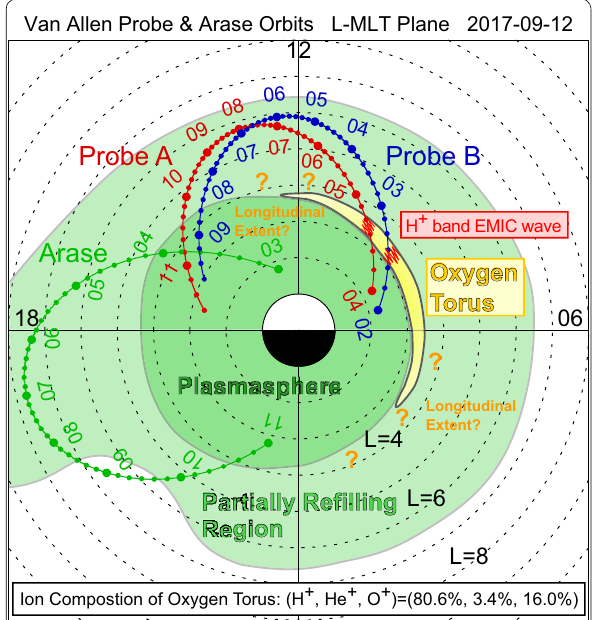
Fig. 11 A schematic figure summarizing findings of the present study for the 12 September 2017